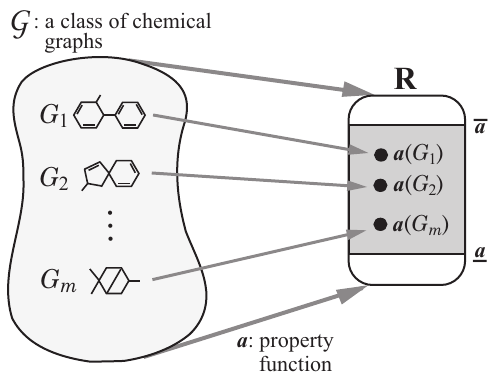
Figure 3. An illustration of Step 1: A data set D π of chemical graphs G i , i = 1,2, . . . , m in a class G